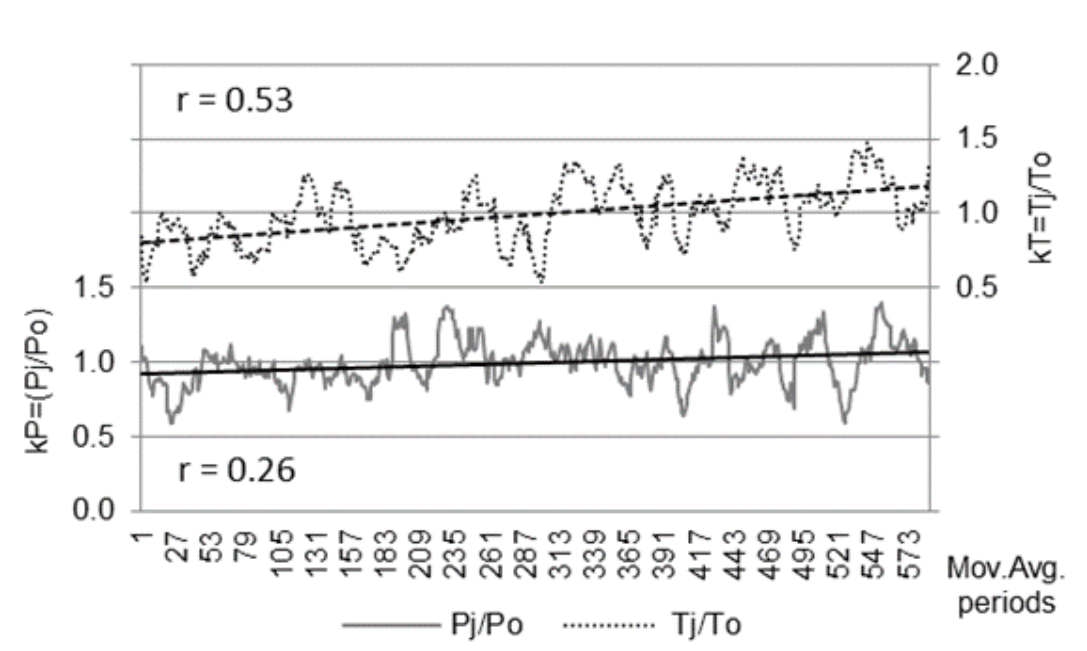
Figure 4. Linear trends in the variation coefficients of air temperature and precipitation ( k respectively) for 12-month moving average (Mov.Avg.) periods during the 50-year study period (see Equation 1). In this Figure and later, r = the regression